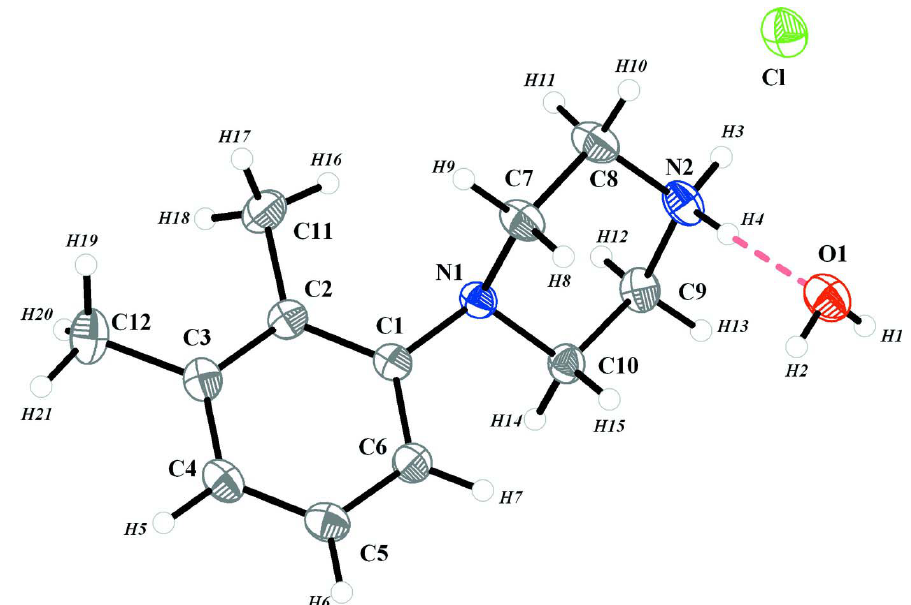
Figure 1 The asymmetric unit of (I), showing 40% probability displacement ellipsoids.